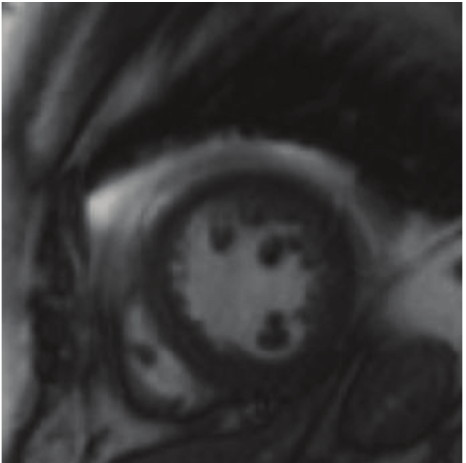
Figure 4: Mid cavitary view of the left and right ventricle on cardiac